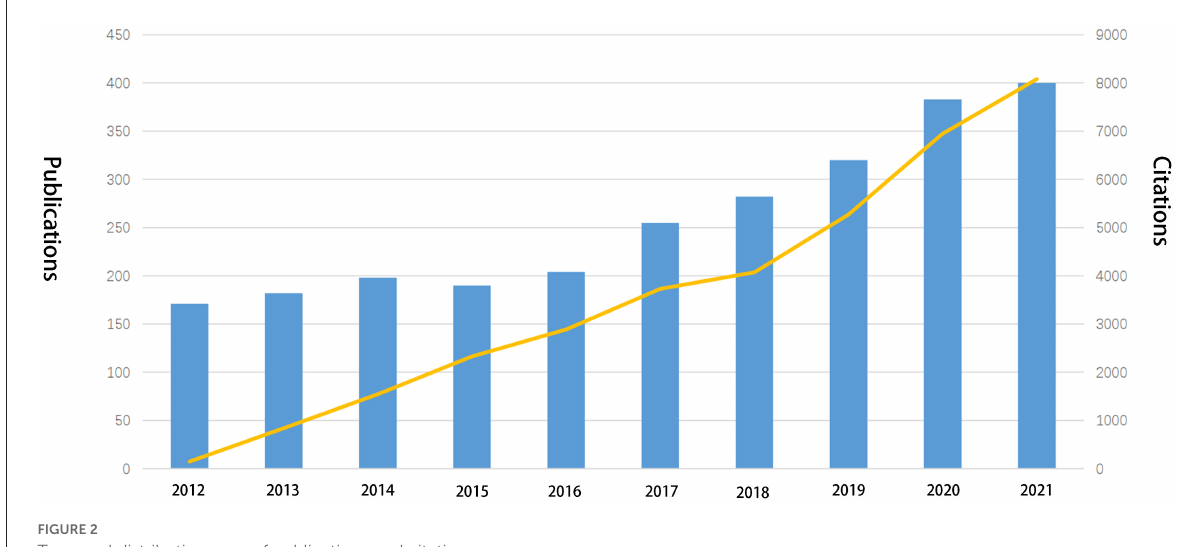
FIGURE2 Temporal distribution map of publications and citations.